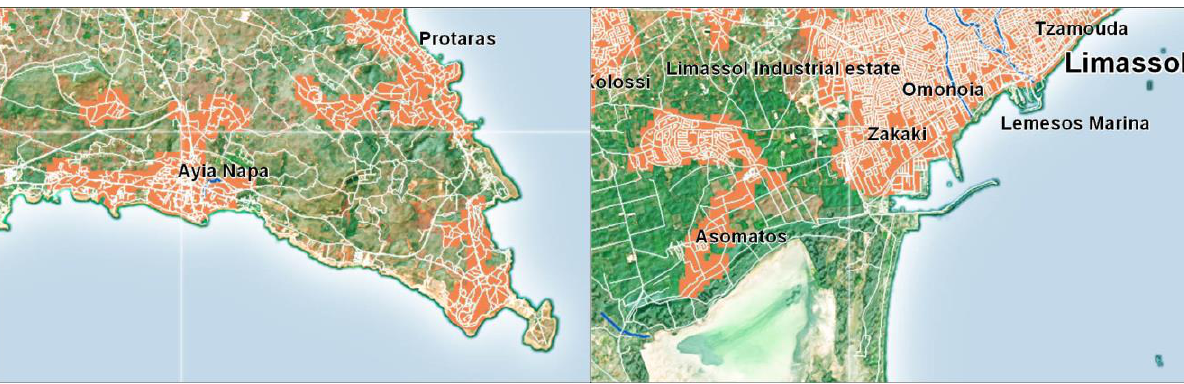
Figure 11. Map of Cyprus: details at scale 1:200